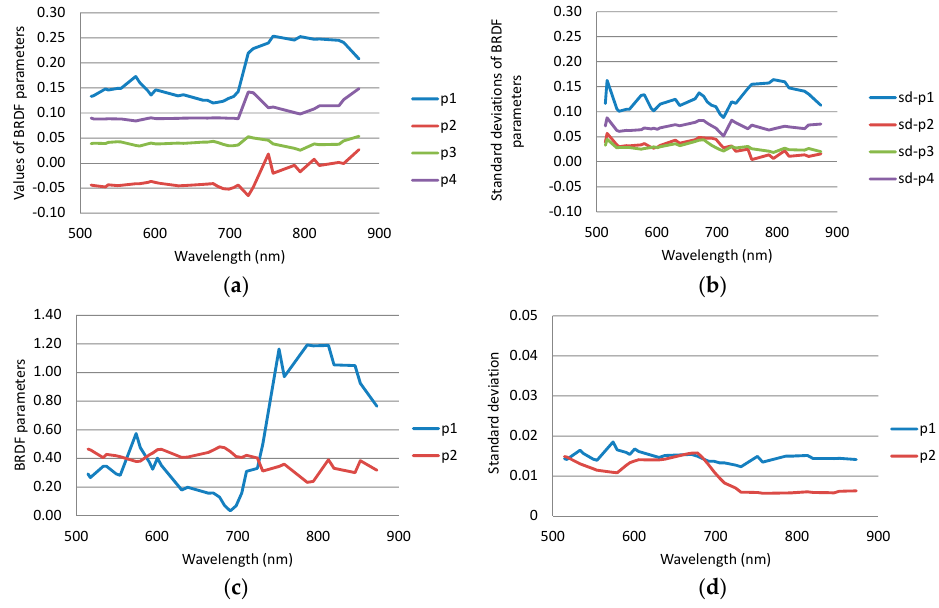
Figure 13. ( a ) BRDF parameters and ( b ) their standard deviations in the 4-parameter case for the full data; ( c ) BRDF parameters and ( d ) their standard deviations in the 2-parameter case for the flight f34.